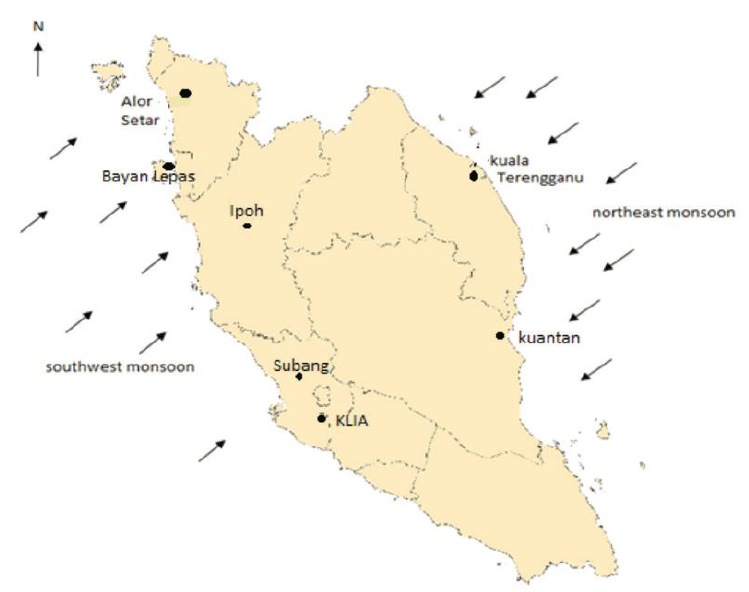
Figure 1. The direction of northeast and southwest monsoon in Peninsular Malaysia [1].